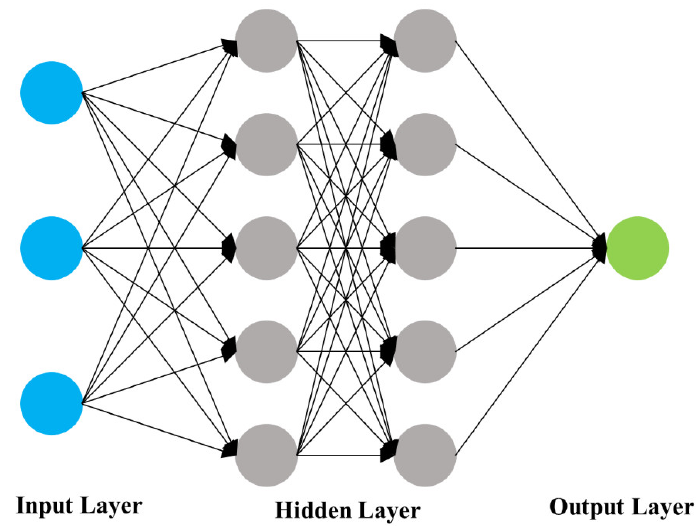
Figure 1. The diagram of artificial neural network (ANN).